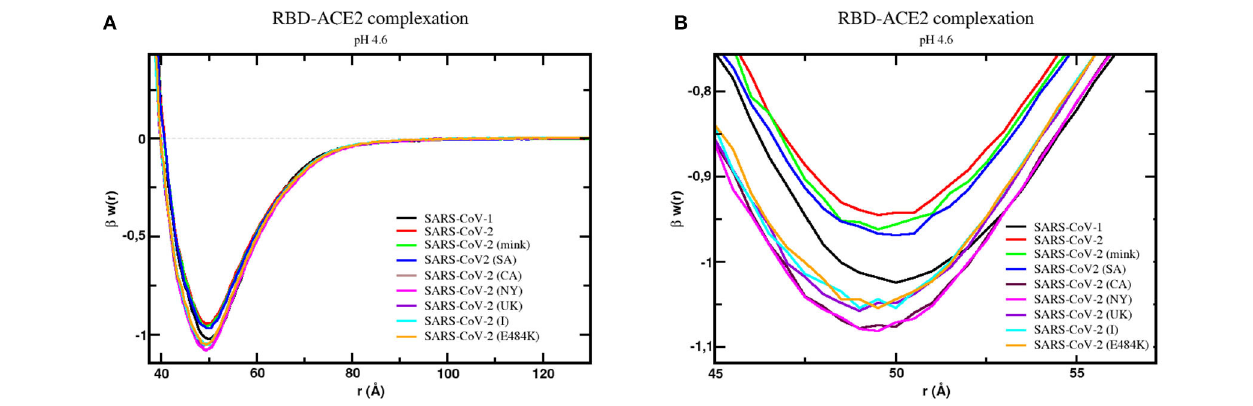
FIGURE 3 | Free energy profiles for the interaction of RBD proteins with the cellular receptor ACE2. The simulated free energy of interactions [ β w ( r )] between the centers of the RBD proteins from SARS-CoV-1, SARS-CoV-2 (wt), SARS-CoV-2 (mink), SARS-CoV-2 (SA), SARS-CoV-2 (CA), SARS-CoV-2 (NY), SARS-CoV-2 (UK), SARS-CoV-2 (I), and SARS-CoV-2 (E484K) and the cellular receptor ACE2 are given at pH 4.6. The source of the three-dimensional structures of these proteins is explained in the text and referred to as RBD1 wt , RBD2 wt , RBD2 m , RBD2 SA , RBD2 CA , RBD2 NY , RBD2 UK , RBD2 I , and RBD2 E484K , respectively. Salt concentration was fixed at 150mM. Data for the complexes with the wildtype proteins (RBD1 wt -ACE2 and RBD2 wt -ACE2) was given in an earlier study ( 8). Simulations started with the two molecules placed at random orientation and separation distance. Results for SARS-CoV-1, SARS-CoV-2 (wt), SARS-CoV-2 (mink), SARS-CoV-2 (SA), SARS-CoV-2 (CA), SARS-CoV-2 (NY), SARS-CoV-2 (UK), SARS-CoV-2 (I), and SARS-CoV-2 (E484K) are shown as black, red, green, blue, dark purple, pink, light purple, cyan, and continuous orange lines, respectively. (A) Full plot. (B) The well depth region of the β w ( r ) for each studied